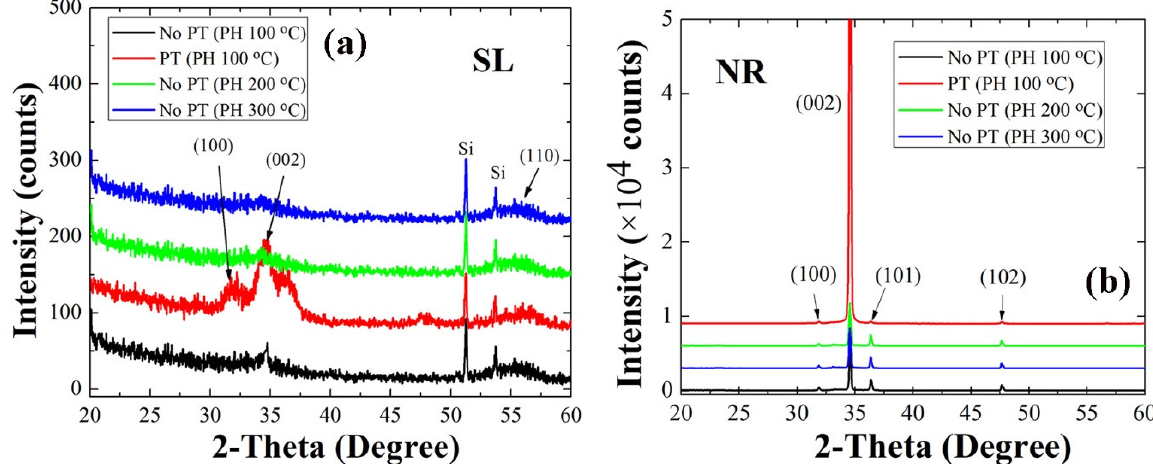
Figure 3. XRD patterns (2θ scan) of ZnO SLs ( a ) and NRs grown on the SLs ( b ) prepared under different conditions. Table 2. Parameters of ZnO NR crystals extracted from XRD analysis.